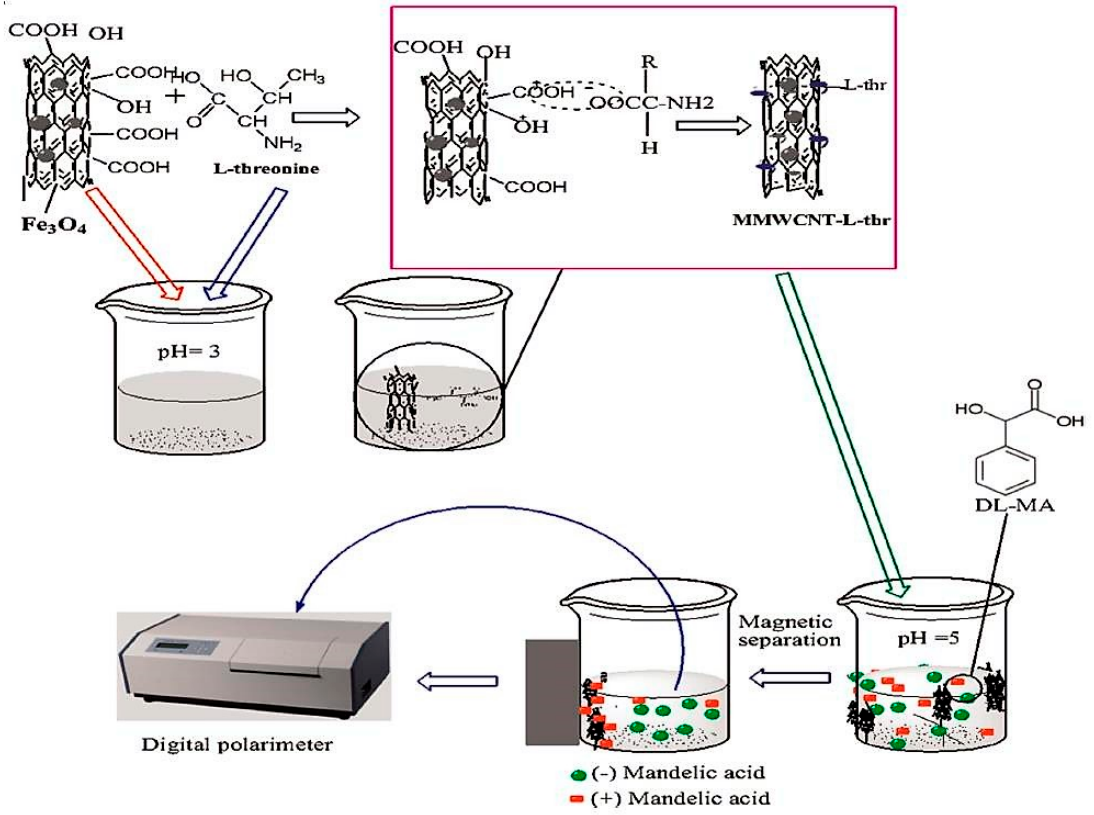
Figure 5. Schematic representation of the enantioseparation of DL -mandelic acid with MMWCNTs- L - threonine “Reproduced with permission from G.D. Tarigh et al. [51]. Copyright Elsevier, 2015”.